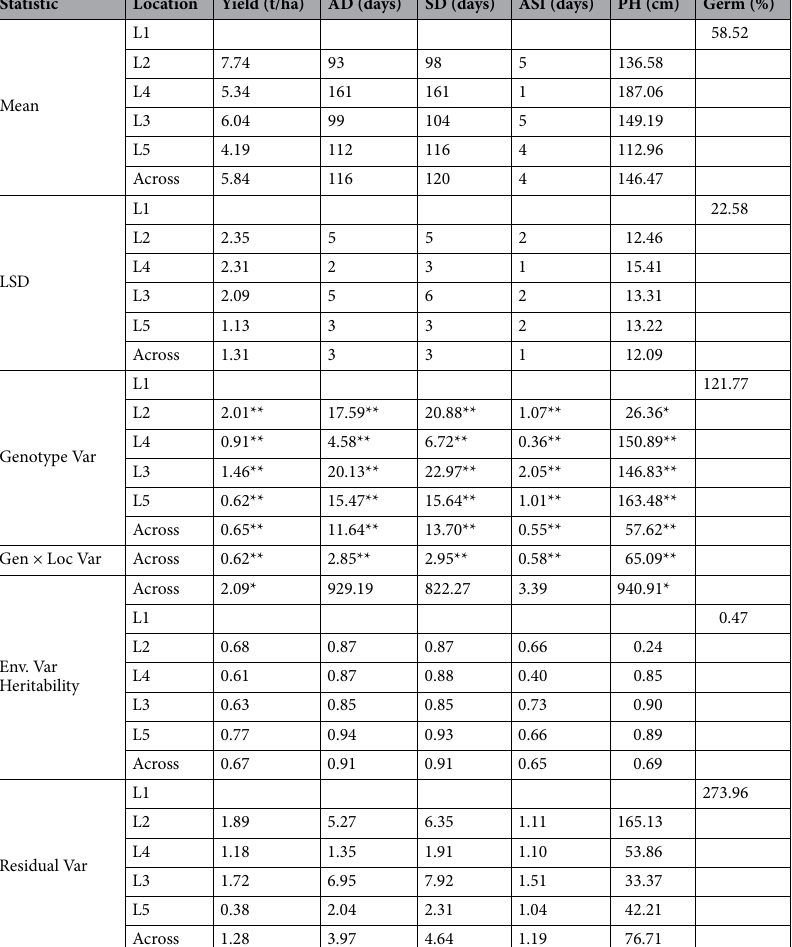
Table 2. Descriptive statistics of test crosses of panel of tropical Asia adapted lines under cold screens. *,**Represents significance at P ≤ 0.01 and ≤ 0.001 respectively. AD, SD, ASI and Germ represents Days to 50% anthesis, Days to 50% silking, Anthesis-silking interval and Germination respectively.